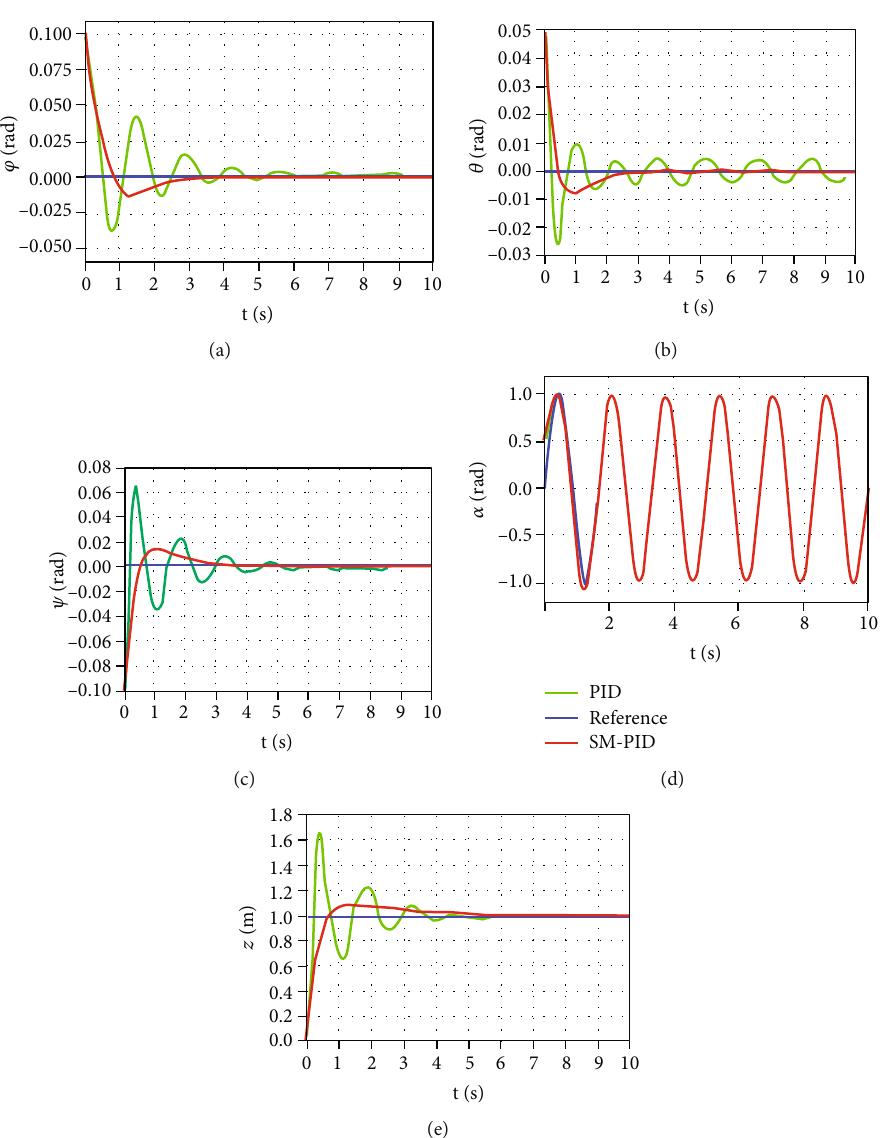
Figure 12: Attitude pro fi les for two controls under sinusoidal motion and perturbation. (a) Rolling angle. (b) Pitch angle. (c) Yaw angle. (d) Pull down tilt angle. (e) Altitude